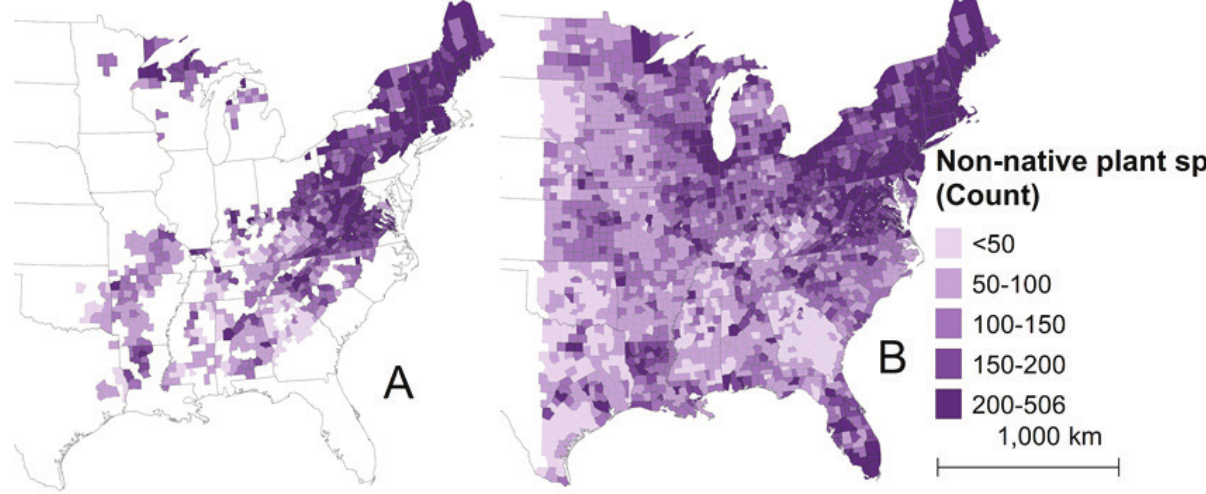
Figure 3. Recorded number of non-native plant species (EDDMapS database; Center for Invasive Species and Ecosystem Health 2020) by county in eastern forests (A) and the eastern United States